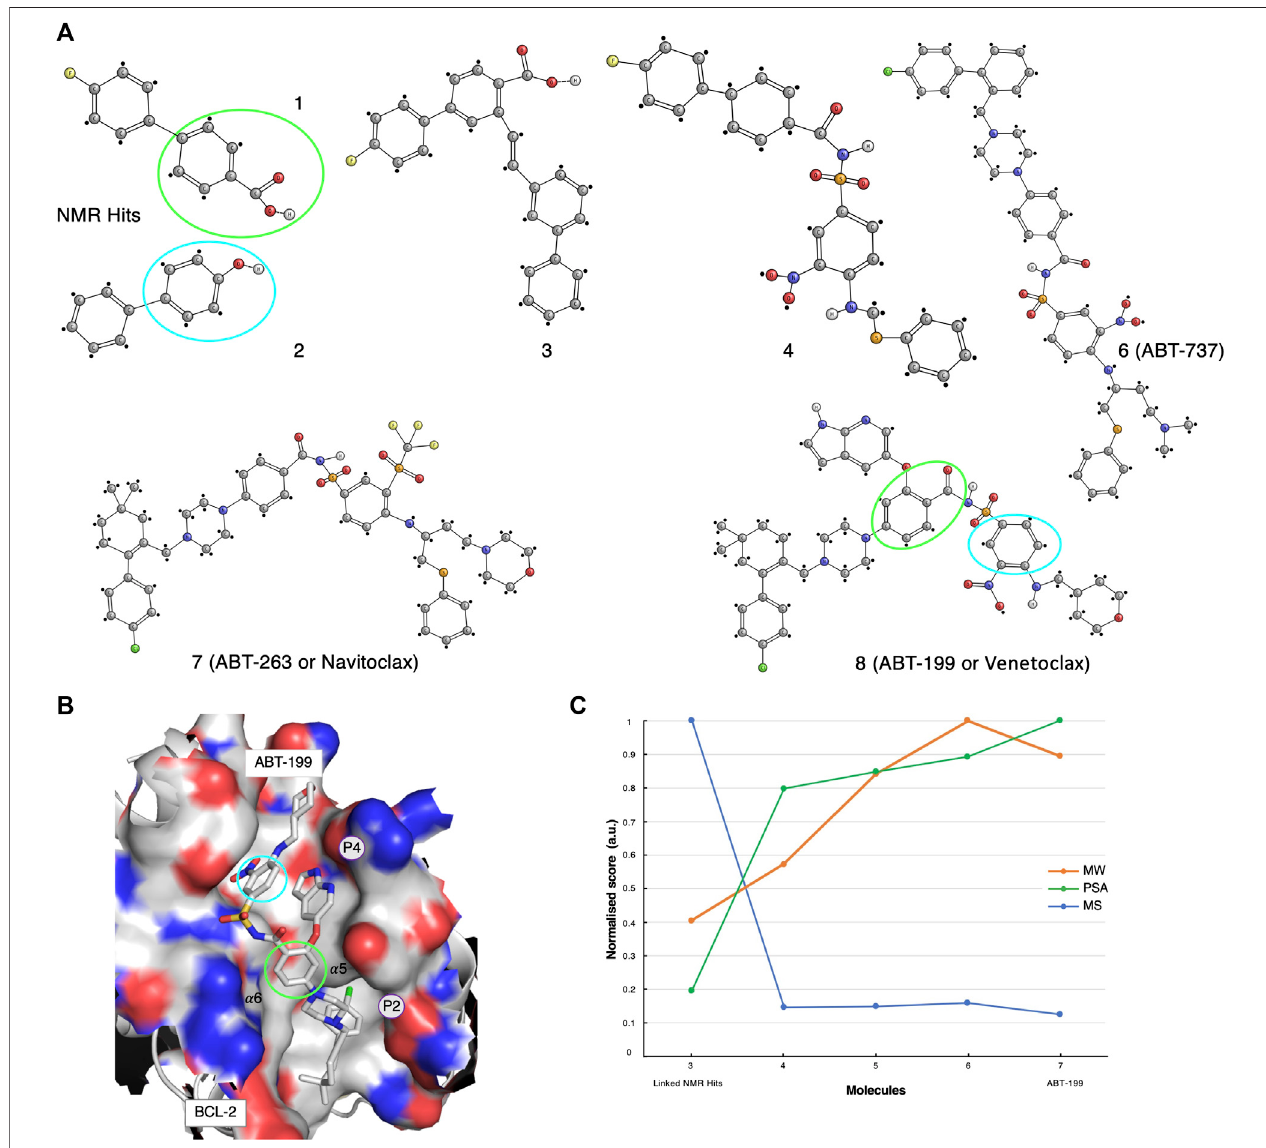
FIGURE 3 | The ABT-199 case-study. (A) Optimisation pathway: from NMR hits to ABT-199. The aromatic moieties of the NMR-determined hits (green and cyan circles) were originally identi fi ed as interacting with BCL-XL active sites (Petros et al., 2006). Compounds 1, 2, 3, 4 were identi fi ed and optimised through NMR methodologies,whereasthelatestABTcompoundsoptimisationsbene fi tedfromX-raycrystallographytechniques(Petrosetal.,2006;Petrosetal.,2010;Souersetal., 2013). (B) Molecular structure representation of BCL-2 in complex with Venetoclax (PDB code: 6O0L). Green and cyan circles indicated the aromatic motifs originallyidenti fi ed throughthe NMRprimary screening. (C) Molecular similarity,asexpressed bytheTanimotocoef fi cient (MS,Blue),normalised molecular weight (MW, orange) and polar surface area (PSA, green) scores for compounds 3-7 on the development path of